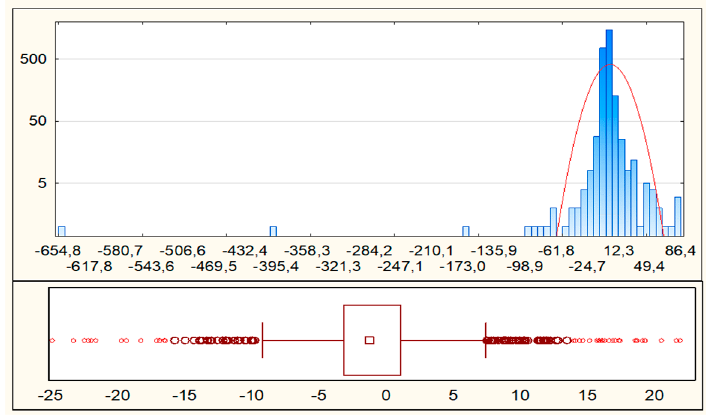
Figure 12. MAPE, 250 m, Poland.